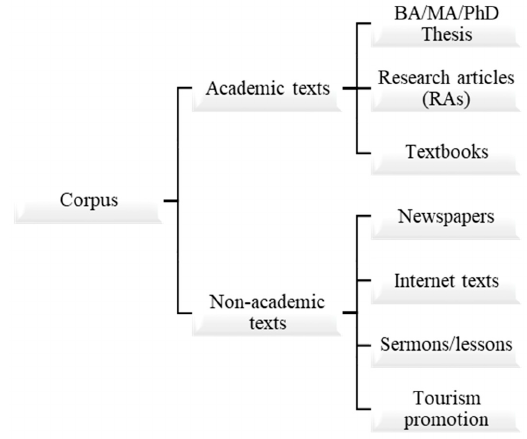
Figure 4. Textual genre classification.